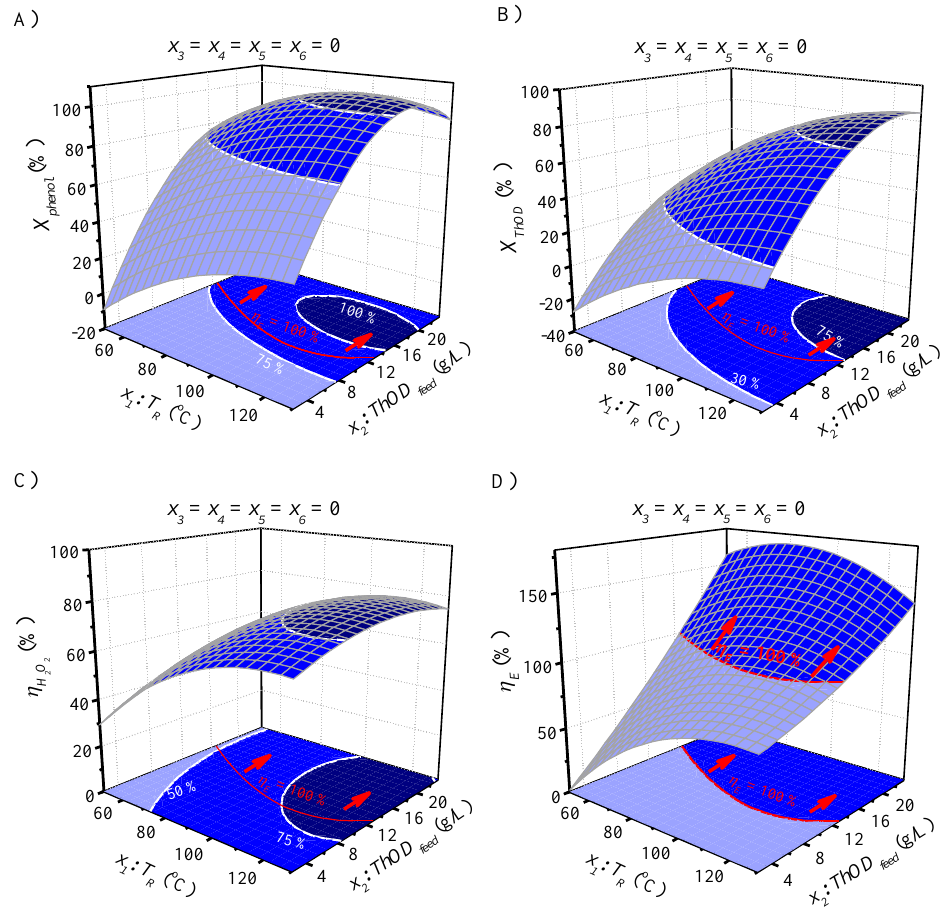
Figure 4. Response surfaces, contour plots and surface projections for X phenol ( A ), X ThOD ( B ), η H2O2 ( C ) and η E ( D ) as predicted by the quadratic models at different T R and ThOD feed values under T output = 45 °C (x 3 = 0), HP excess = 100 (x 4 = 0), τ = 165 g h mol -1 (x 5 = 0) and T input = 20 °C (x 6 = 0).